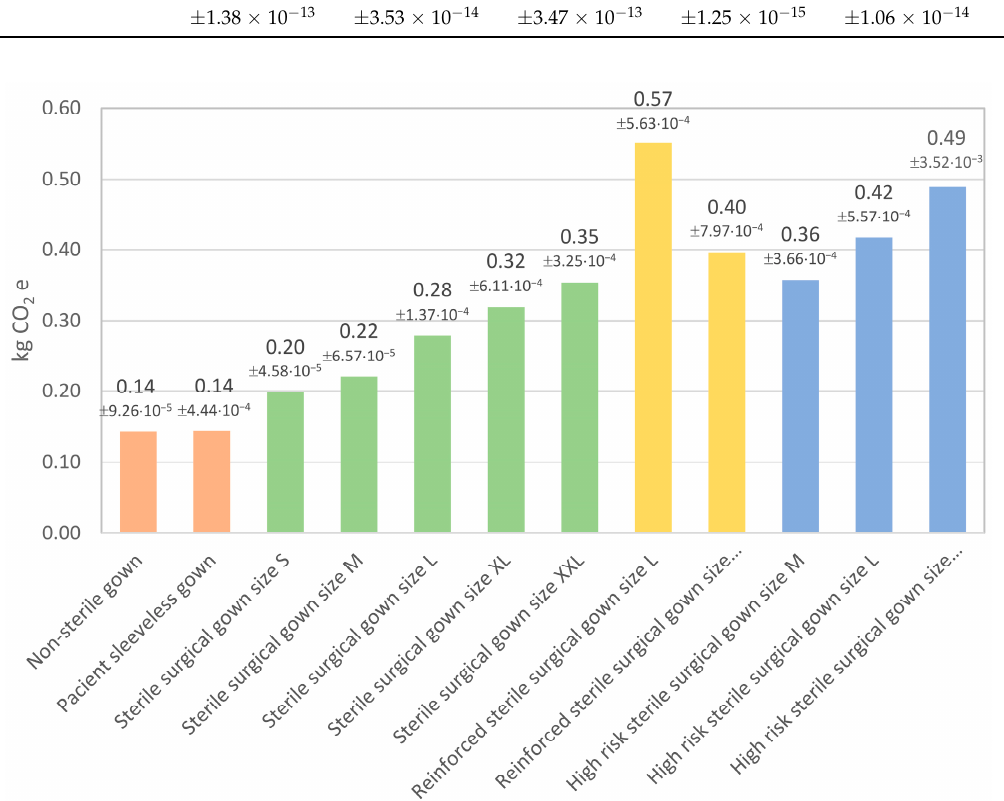
Figure 1. Carbon footprint of one gown unit.